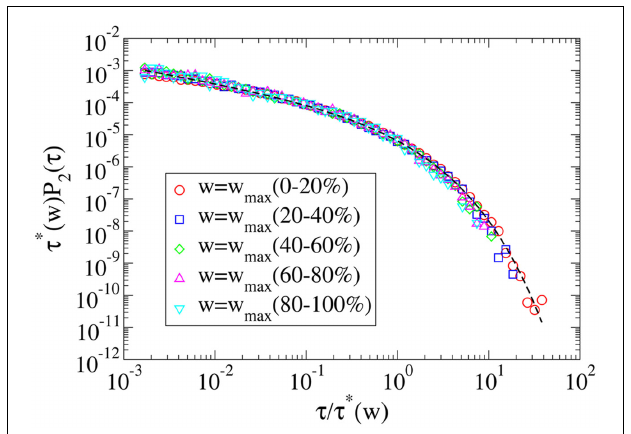
FIGURE 3 | Data of the simulation of the proposed model for cell FIGURE 1 | Data collapse of the simulation of the proposed model for phone communication for β = 1. In the figure we plot the probability cell phone communication with β = 0.5. In the figure we plot the (τ) that in the model a pair of agents with strength w are interacting for P w 2 (τ) that in the model a pair of agents with strength w are probability P w (τ) is described by power-law a period τ .The collapses data of P w 2 2 (τ) is described by interacting for a period τ .The collapses data of P w distribution in agreement with the theoretical predictions. In the inset we 2 Weibull distribution as expected by the theoretical prediction indicated with report the power-law exponent versus the theoretically predicted power-law a solid line. exponent showing good